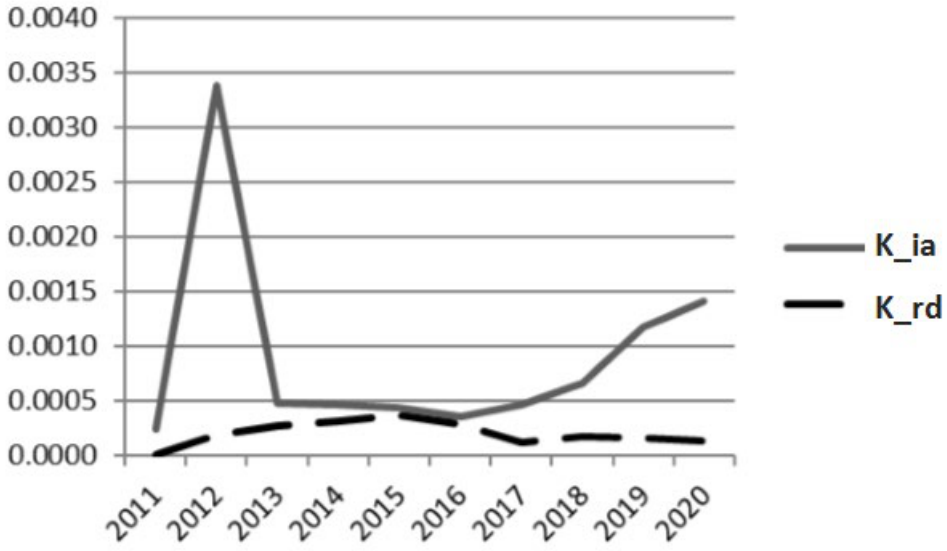
Figure 16. Coefficients of the intangible assets (K_ia) and R&D costs (K_rd) for the PJSC “Sev- erstal”.